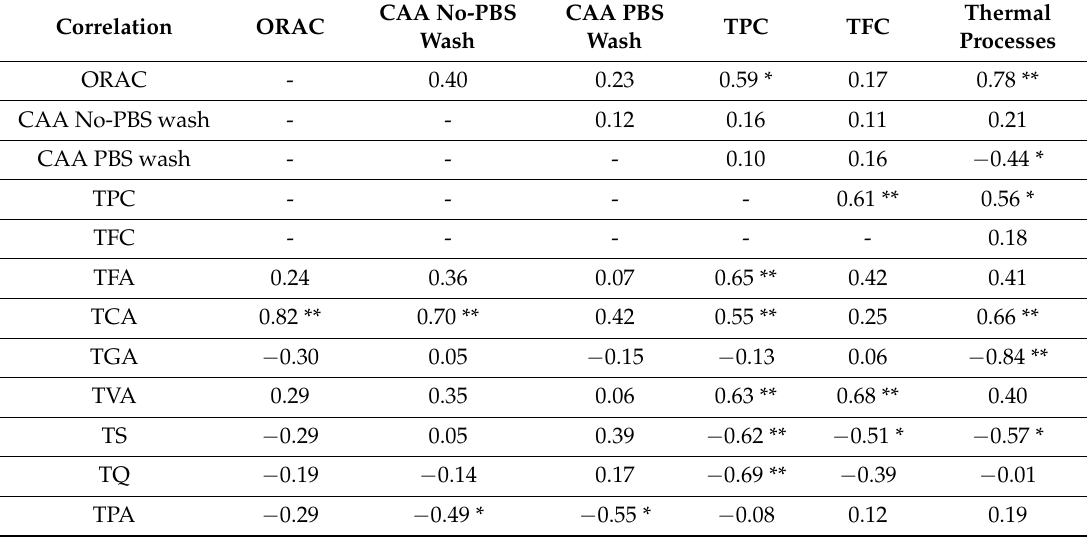
Table 3. Pearson correlation coefficient among phenolic profiles, contents and total and cellular antioxidant